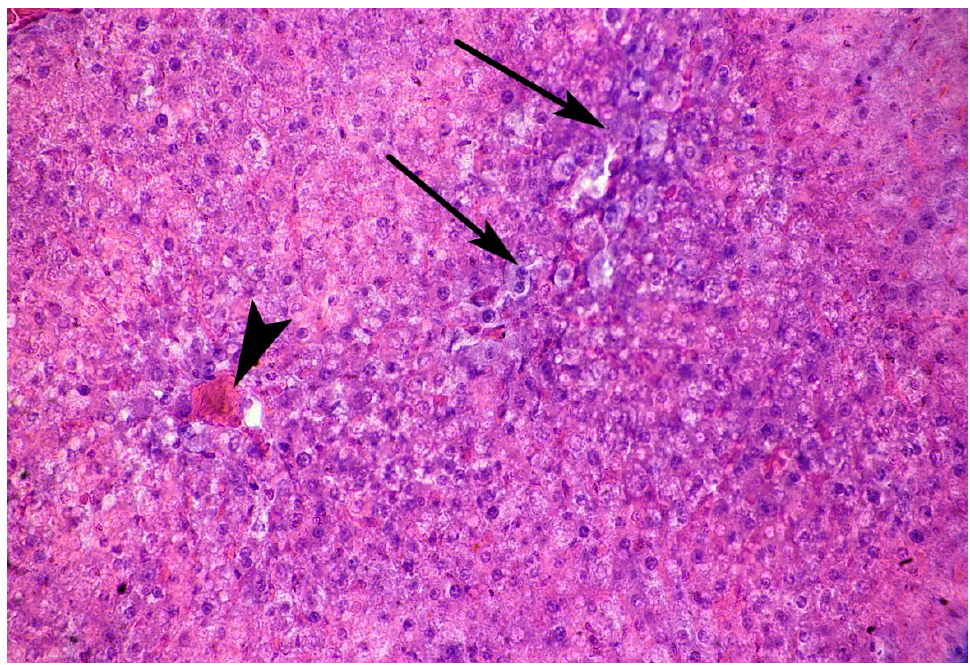
Figure 5. Photomicrograph of the liver. Juvenile rats, 5th day after mTBI. Focal necrosis and dystrophic hepatocytes with light cytoplasm and vacuoles (arrow), the blood stasis in the central vein (arrowhead). H E, ×400.